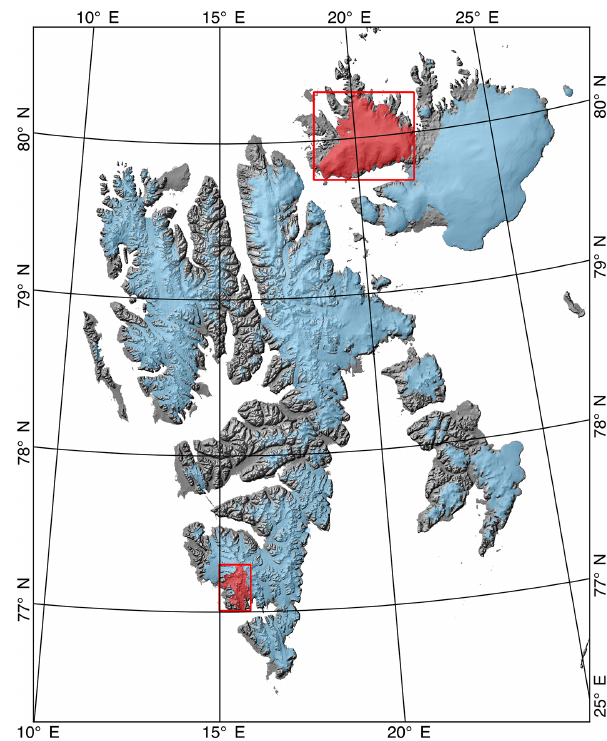
Figure 1. Overview map of the Svalbard archipelago showing ice coverage (blue shading). The three test sites are located in two areas on the archipelago (red shading and rectangles). The test sites are Vestfonna ice cap (VIC) on Nordaustlandet, the glacier complex comprising the marine-terminating Austre Torellbreen, Hansbreen and Paierlbreen (THPB), and the land-terminating Werenskiold- breen (WSB) in Wedel Jarlsberg Land. Background: grey-scale hill- shaded topography based on a 50m DEM from the Norwegian Po- lar Institute (NPI; http://publicdatasets.data.npolar.no/kartdata/NP_